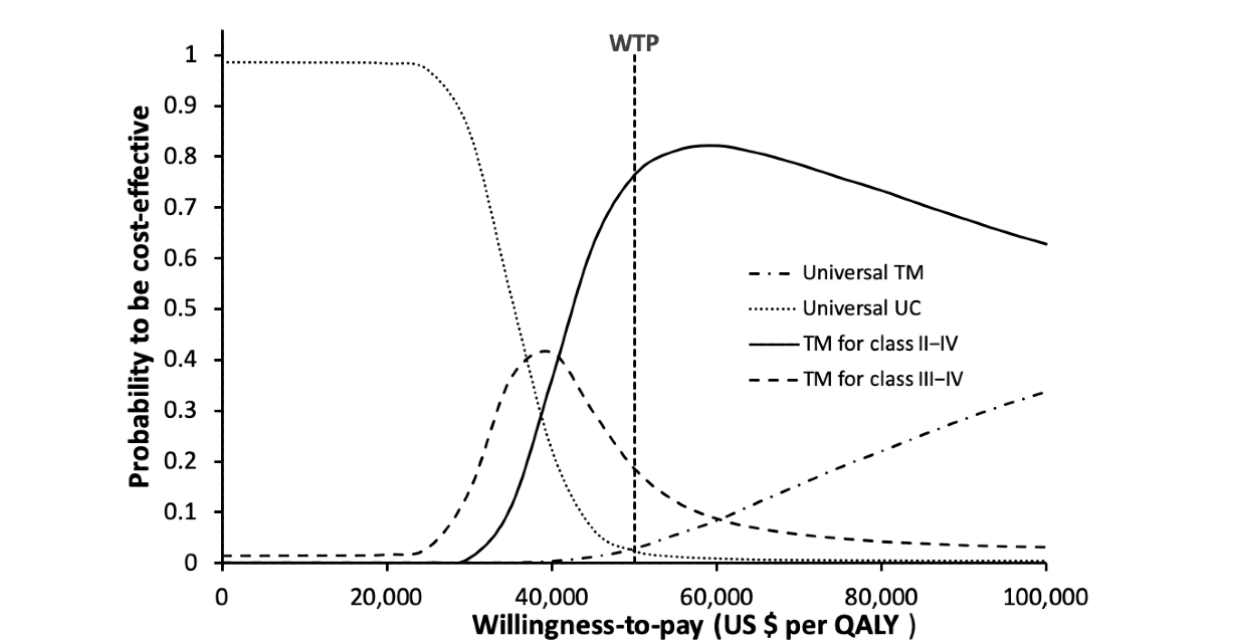
Figure 4. Cost-effectiveness acceptability curve for each strategy to be preferred option against the willingness-to-pay threshold. QALY: